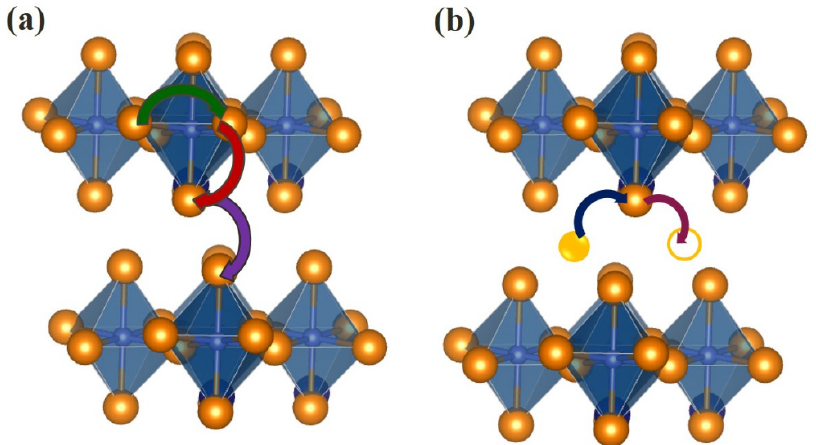
Figure 6. 3D representation of the vacancy ( a ) and interstitial ( b ) oxide ion migration in doped A II LnInO 4 .